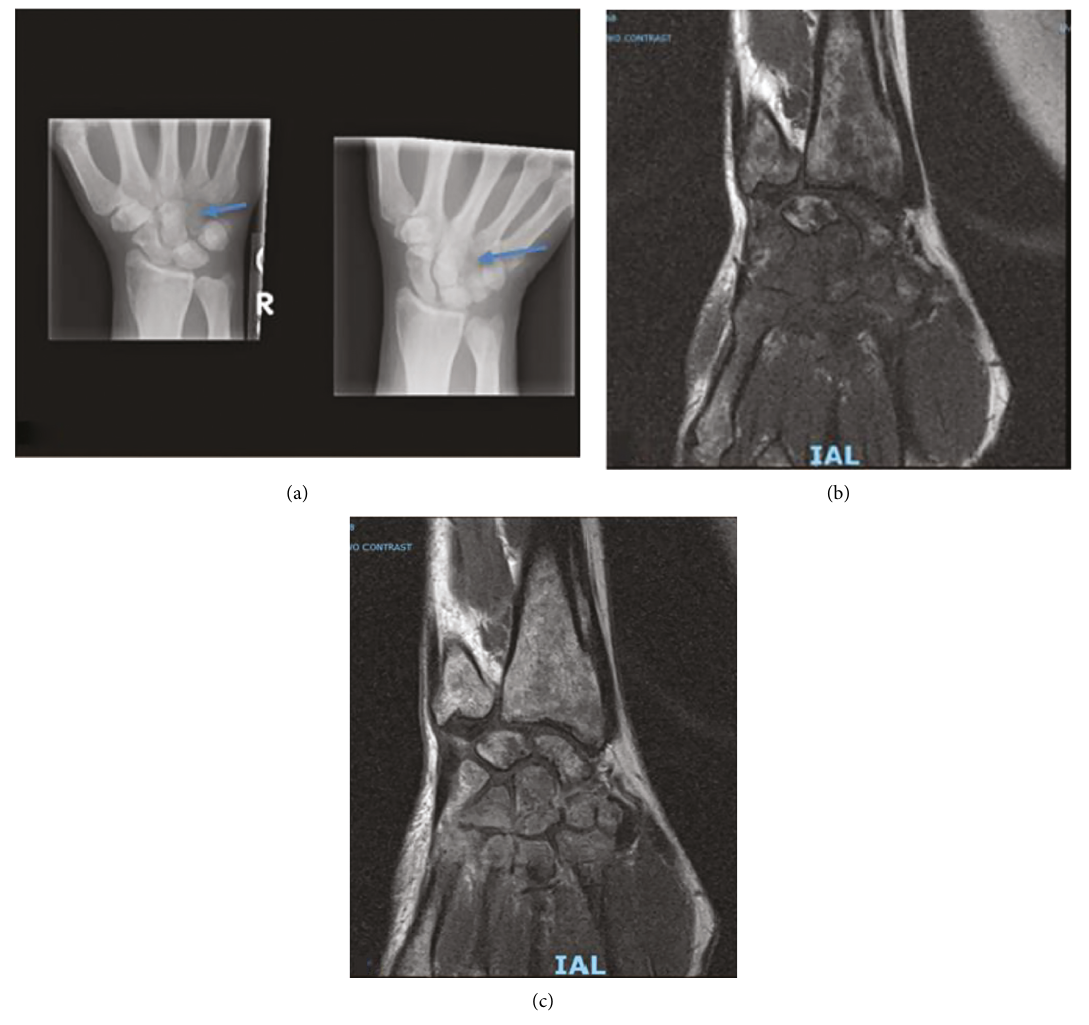
Figure 4: (a) Plain film X-ray of the right hand reveals diffuse severe lucency of the entire hamate bone (blue arrows) with a thin peripheral cortex visible. (b) T1 MRI. (c) T2-weighted MRI with contrast of the right hand reveals severe bone marrow replacement throughout the distal radius and ulna, carpal bones, and metacarpals with complete replacement of the trapezoid, capitate, and hamate.